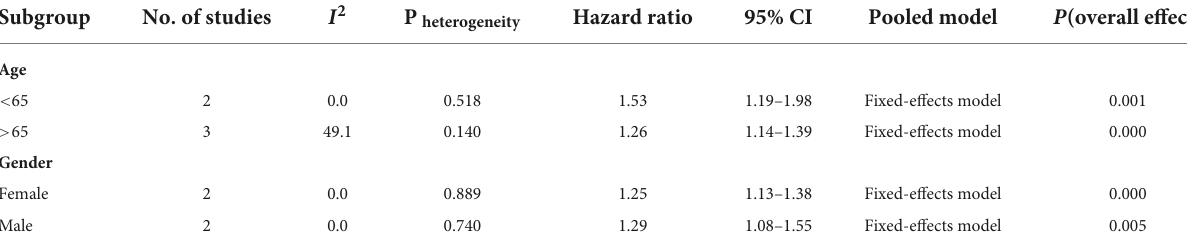
TABLE 3 Subgroup analysis of the association between SS and risk of